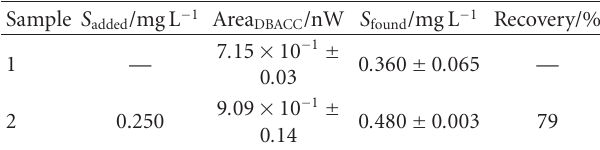
Table 4: Recovery results for real naphtha sample, pure and forti-